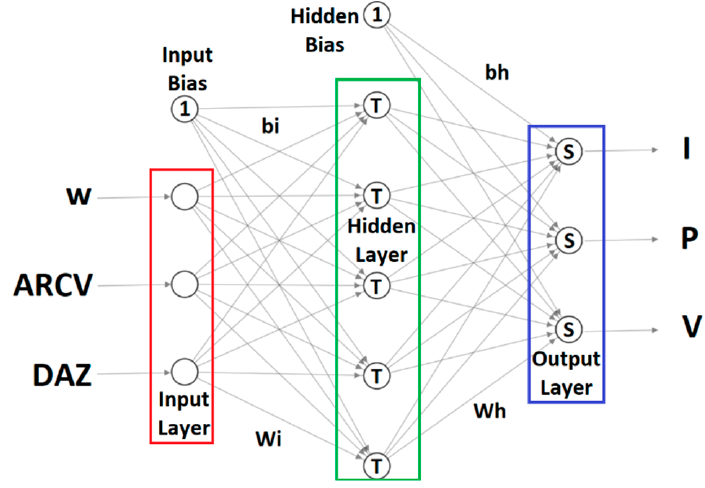
Figure 2. Pattern recognizer ANN architecture.